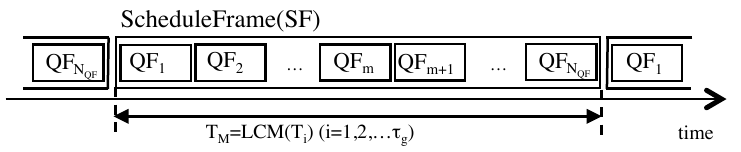
Figure 5. A composition of a ScheduleFrame